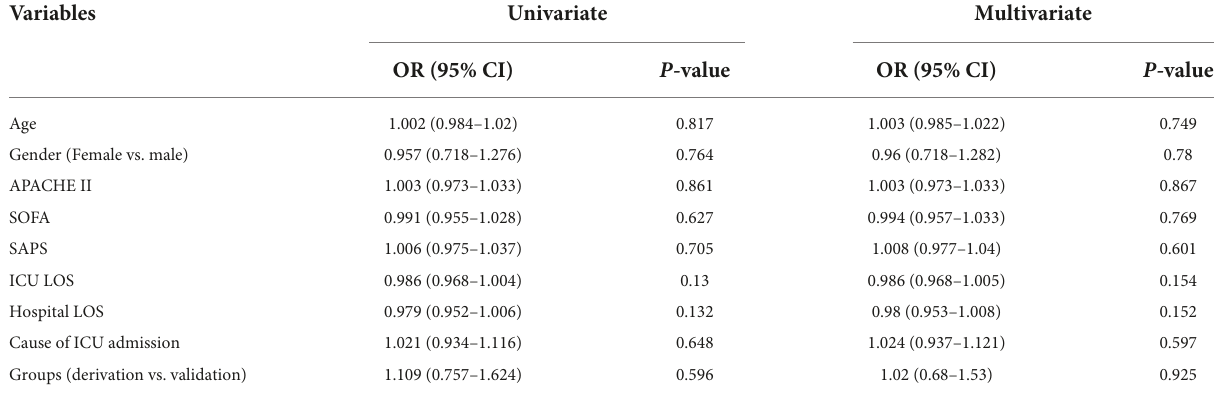
TABLE 2 Univariate and multivariate logistic regression analysis to determine the effect of demographic characteristics and clinical data on weaning outcome. Variables